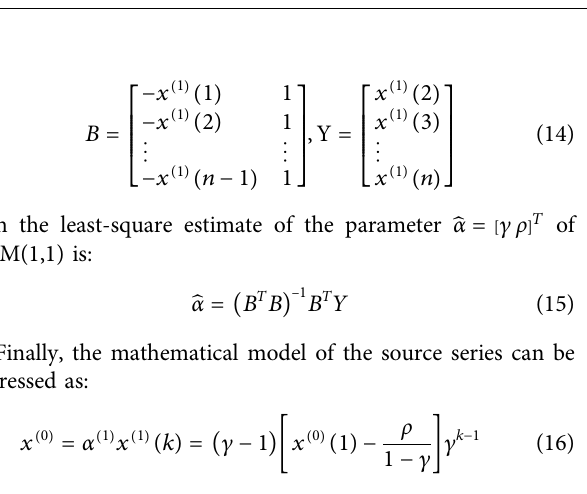
FIGURE 11 | Sampling points with daily peak cluster output power in different